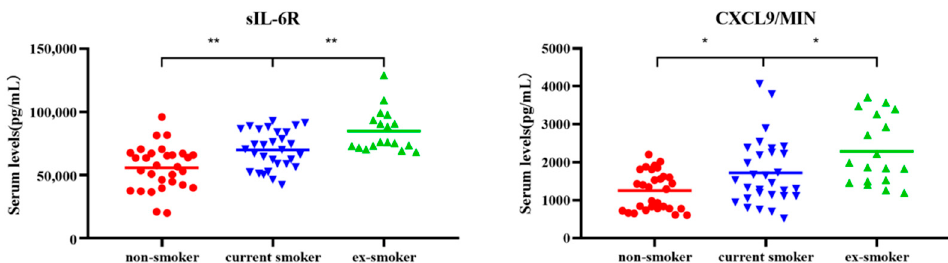
Figure 1. Scatter plots of serum levels (pg/mL) of cytokines CXCL9/MIG and sIL-6R for non-smokers ( n = 30), current smokers ( n = 30), and ex-smokers ( n = 18). Whiskers were calculated using the Tukey method. Outliers not shown. * p < 0.05, ** p < 0.01: Kruskal–Wallis test and Dunn’s multiple comparison test.